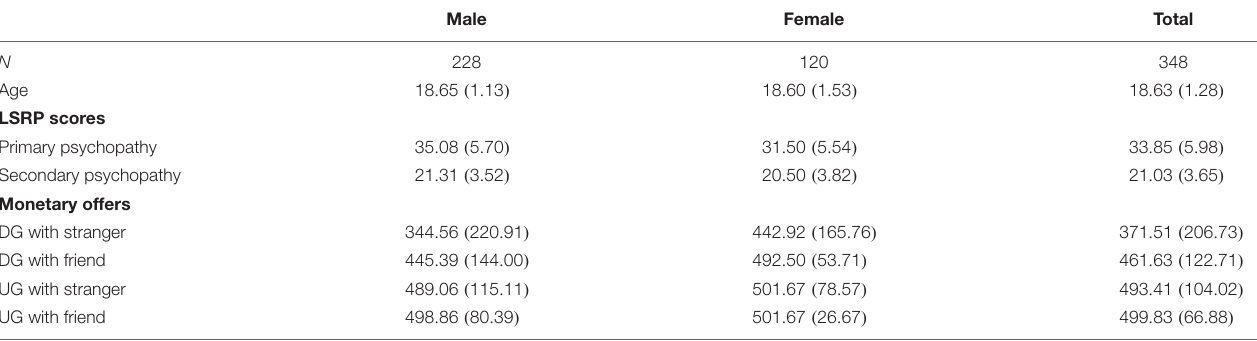
TABLE 1 | Characteristics of male and female participants.